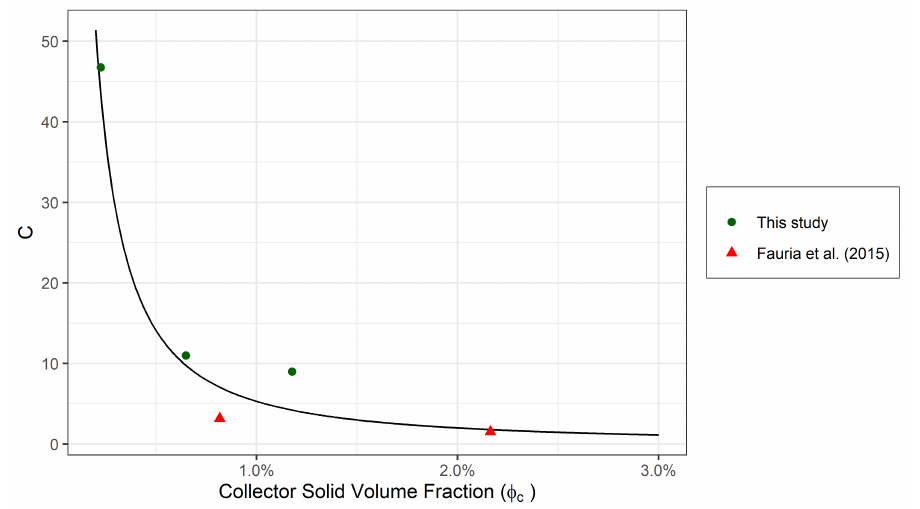
Figure 9. A comparison of the C values (Equation (4)) for each of our collector-density treatments to those calculated by Fauria et al. [10]. The black line represents the power-law model of best fit (R 2 = 0.82) between C and collector solid volume fraction ( φ c ) for our collector-density treatments combined with those of Fauria et al. (n =